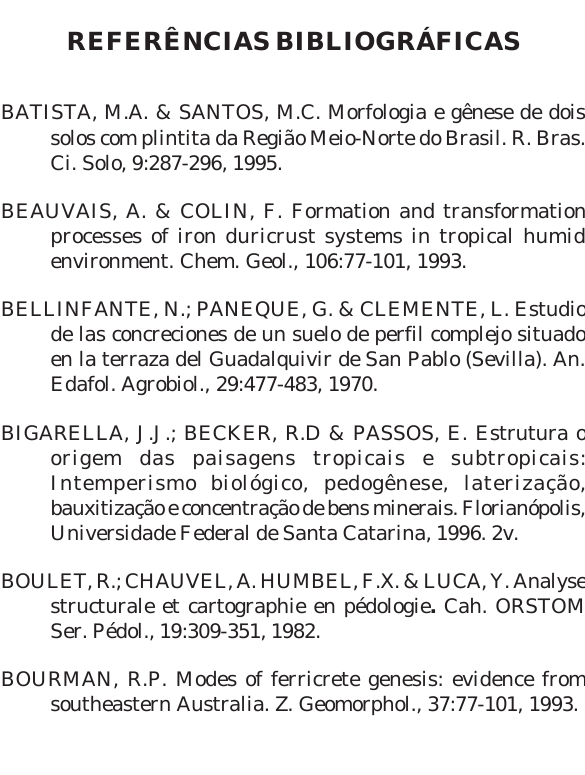
Figura 13. Detalhes do córtex goethítico eviden- ciando o estádio de degradação das glébulas. Luz normal -